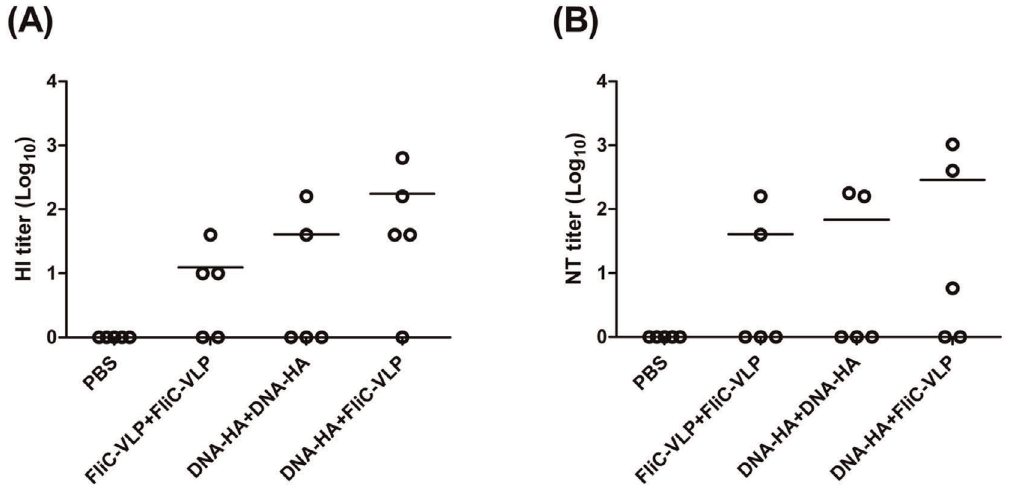
Figure 2. HI and NT titers against the NIBRG-14 virus. Neutralizing activities in sera collected from immunized mice were determined by measuring (A) HI and (B) NT titers against the NIBRG-14 (clade 1) H5N1 influenza virus. Results showed that the DNA-HA vector priming/FliC-VLP booster regiment elicited the highest magnitude of neutralizing antibodies. For calculation purposes, undetectable titers were scored as 1. Individual titers (points) and geometric means (lines) are given for each group.